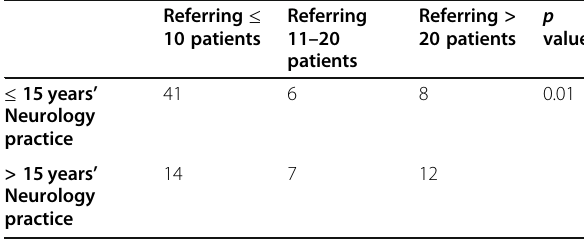
Table 2 Association between years of experience practicing Neurology and number of